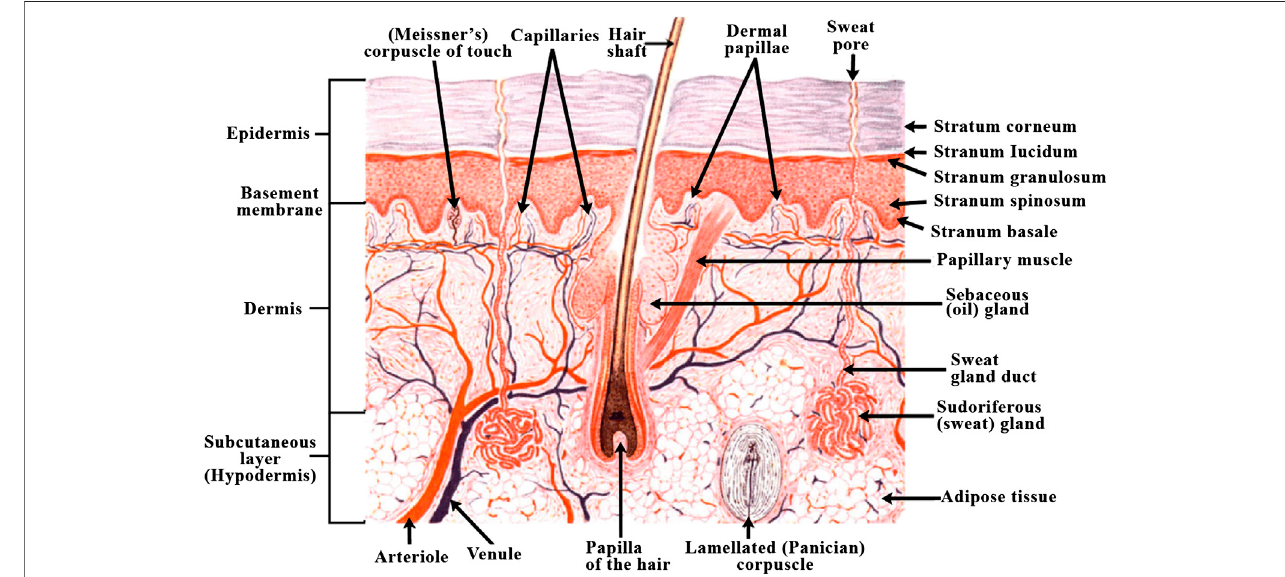
FIGURE 6 | Diagram of human skin structure (Varkey et al., 2019) (used from an open access journal).